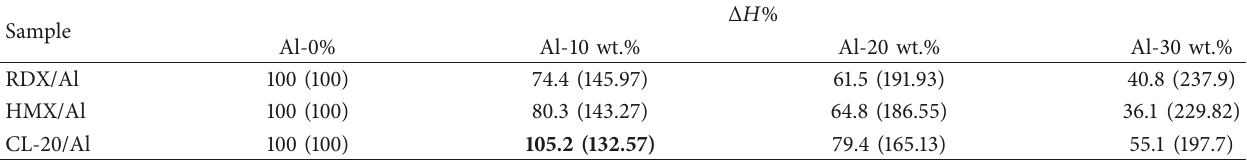
Table 4: Exothermic enthalpy percentage of the three groups of